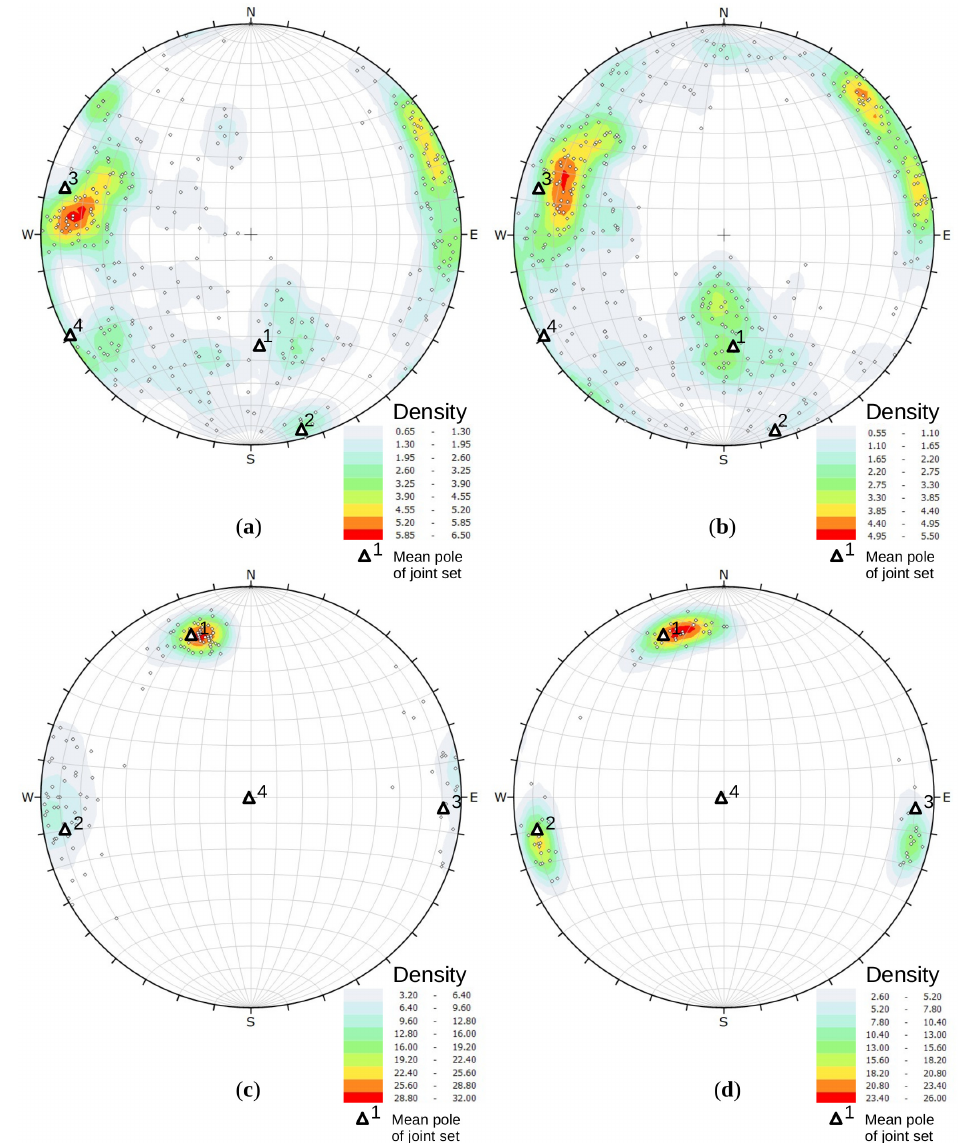
Figure 5. Mine A lower hemisphere equal area stereonets with ( a ) virtual mapping data (311 pole vectors) and ( b ) the DFN model (361 pole vectors). Mine B lower hemisphere equal area stereonets with ( c ) virtual mapping data (132 pole vectors) and ( d ) the DFN model (75 pole vectors). The bedding planes at Mine B were not included in the stereonets because they would only appear as a point with high concentration. Mean poles of joint sets described in Tables 3 and 4 are labelled as triangles in the